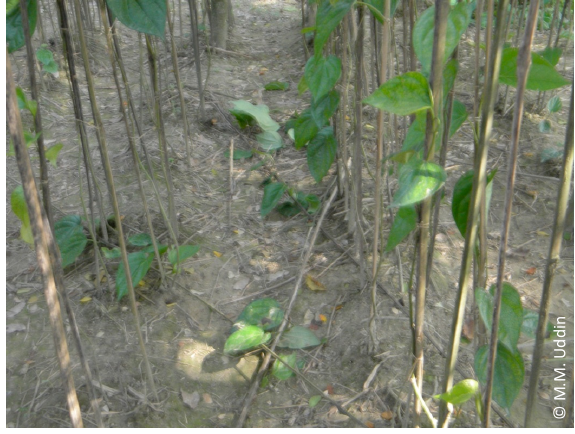
Image 2. Damaged in betel leaf vines by Rhesus Macaques